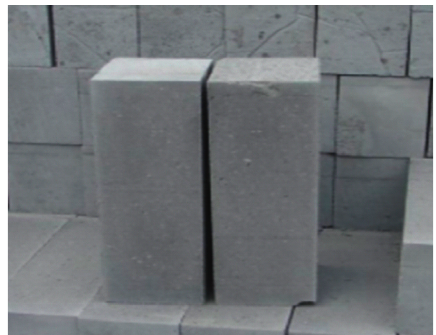
Figure 1: Aerated concrete block.